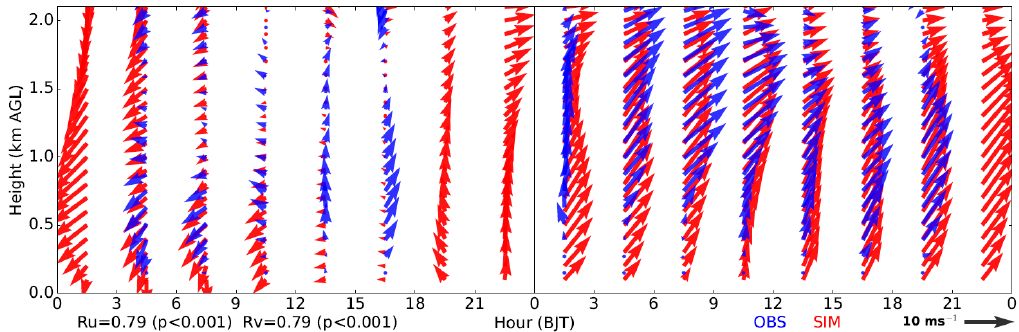
Figure 3. Time-height cross sections showing simulated ( a ) wind speed (WS) and ( b ) potential temperature (PT) in Beijing on 20 September 2015, overlaid with horizontal wind vector fields. The simulated planetary boundary layer (PBL) height is presented as the solid purple line, which is derived using the bulk Richardson number approach. The simulations are derived from the nearest grid point to the wind-profiler site.